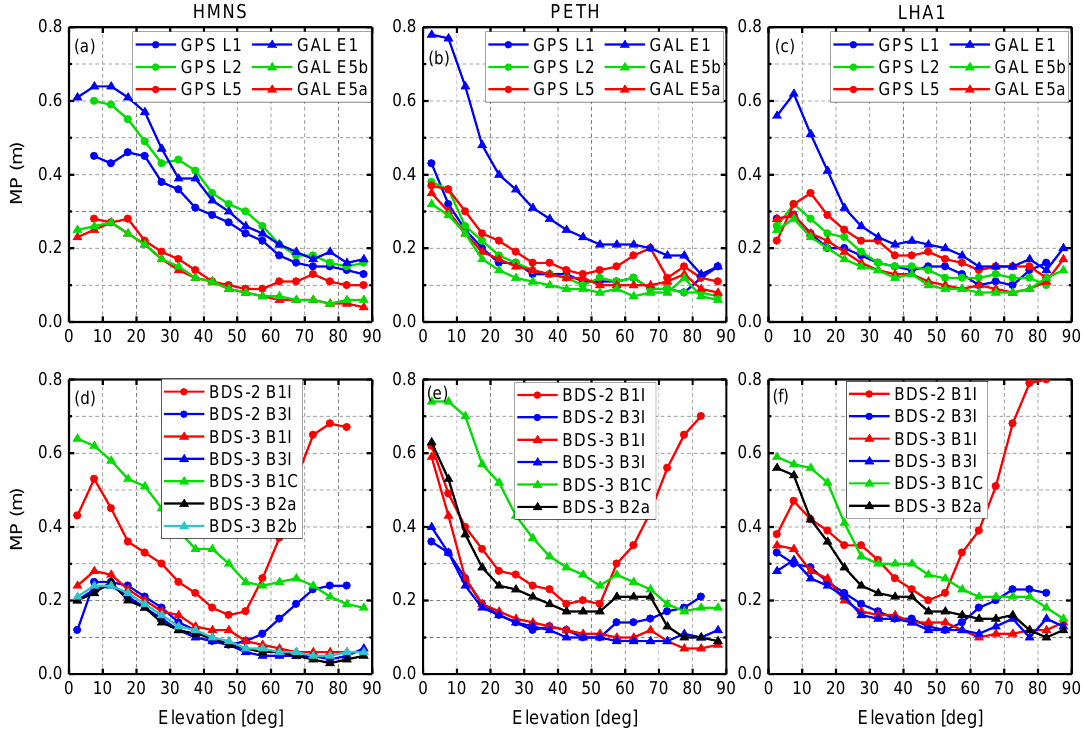
Figure 4. RMS of the noise and multipath errors as a function of satellite elevation for all the available signals of GPS and Galileo ( a – c ) and BDS-2 and BDS-3 ( d – f ) at station HMNS equipped with GNSS_GGR receiver ( a , d ); station PETH equipped with CETC-54-GMR-4011 receiver ( b , e ); and station LHA1 equipped with CETC-54-GMR-4016 receiver ( c , f ), respectively.